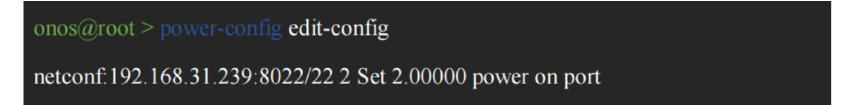
Figure 10. Snapshot of NETCONF-based queries to change the output power of the laser in an emulated optical agent commanded from ONOS.